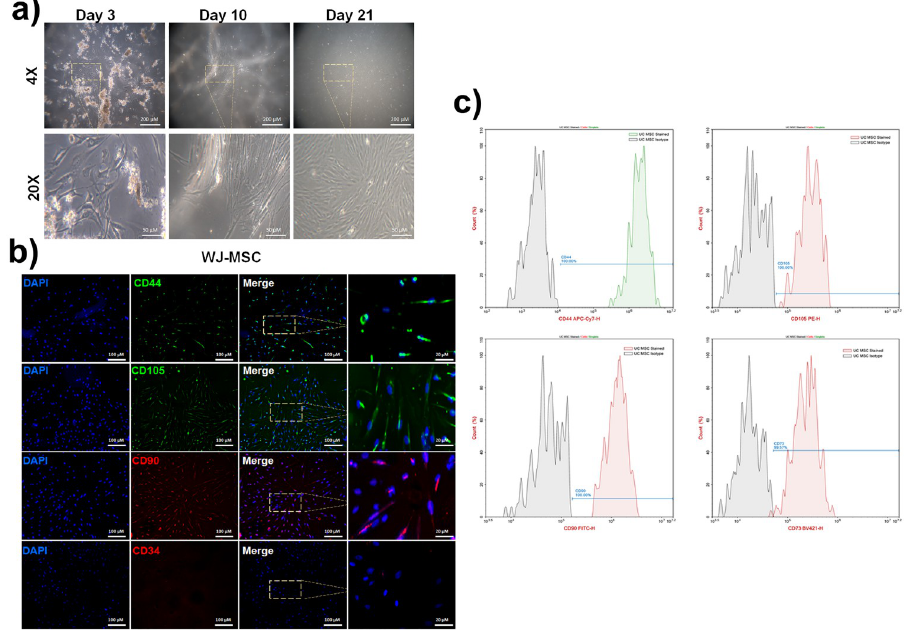
Fig 1. Morphology and characterization of WJ-MSC cells a) Morphological images of WJ-MSC cells on day 3, day 10, and day 21 with scale bar 200 μ m and 50 μ m respectively b) Binding of WJ-MSC CD44, CD90, CD73, and CD105 by flow cytometry c) WJ-MSC also CD34, CD44, CD90, and CD105 staining by IF